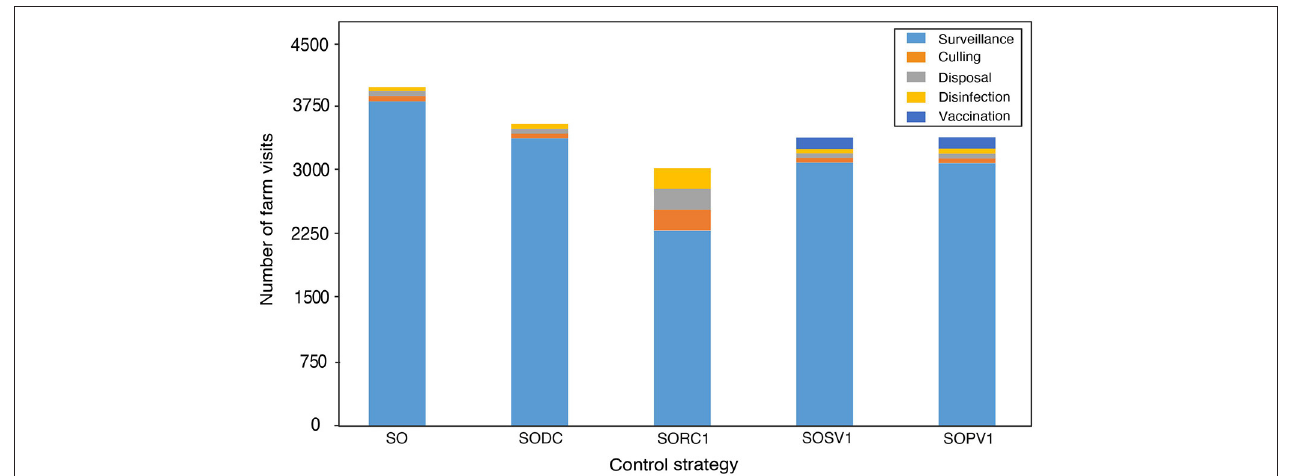
FIGURE 3 | Comparison of overall operational visits to farms split by the type of key operational activities within various control strategies (median values). The considered control strategies are: SO, stamping out of all infected herds (reference scenario); SODC, pre-emptive depopulation of dangerous contact herds; SORC1, pre-emptive depopulation of all susceptible herds within 1km radius around infected herds; SOSV1, suppressive vaccination of all susceptible herds with 1km radius around infected herds; SOPV1, protective vaccination of all susceptible herds with 1km radius around infected